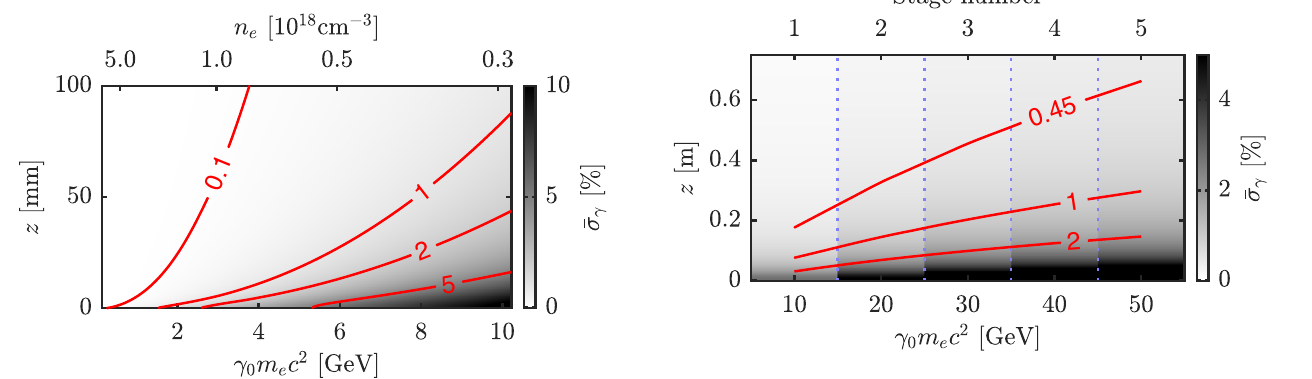
FIG. 8. Relative increase in energy spread per stage due to ICS with the drive laser removed by a 45° plasma mirror. The λ ¼ 1 μ m laser is assumed to be externally guided in each stage with a ¼ 70 μ m and a ¼ 1 . 5 . Isolines of 1% matched spot size of σ 0 x and 2% relative energy spread increase per stage are marked alongside the required value (0.45%) to achieve a final energy spread of 1% at 50